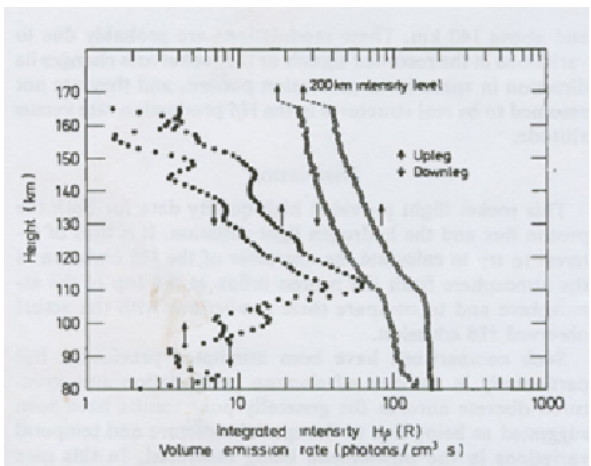
Figure 9. The H β intensities measured by the Proton 1 rocket pho- tometer during its ascending and descending trajectories. Some re- duction in intensity appeared on the way down. Peak emissions were detected at the same altitude. Integrated intensities, recorded during the up and down legs, are shown to the right (Søraas et al.,